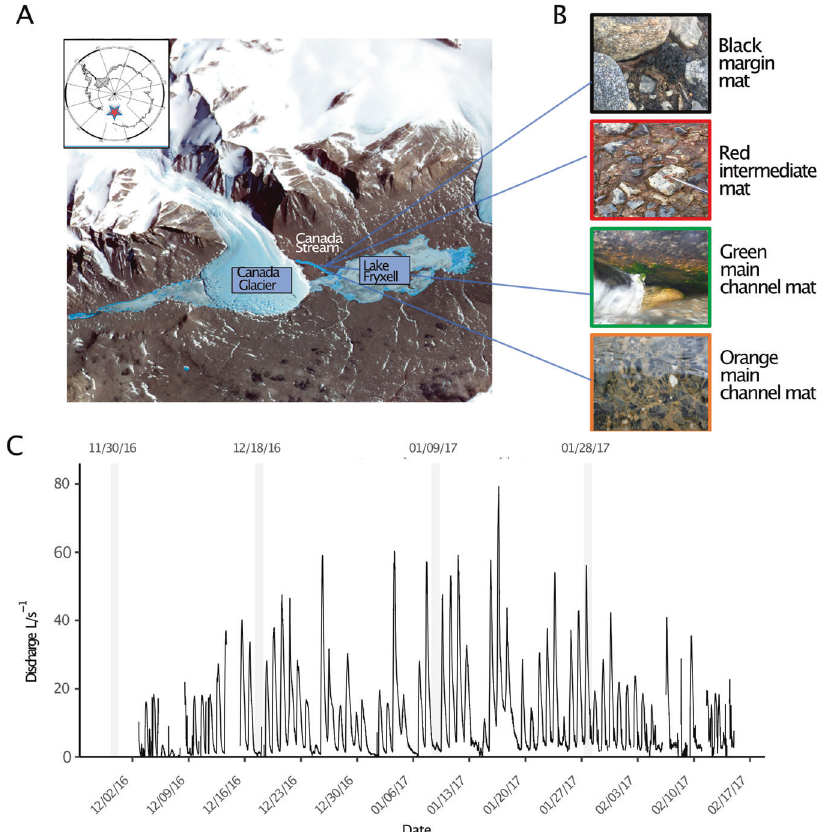
Fig. 1 Sampling site and stream features. A Map of Lake Fryxell Basin, Taylor Valley, Antarctica showing placement of the Canada meltwater stream. B Visuals of the four mat types found along the Canada stream margins and within the main channel. C Hydrograph showing the seasonal discharge rate (L/s) of Canada stream fl ow from data collected every 15 minutes over 12